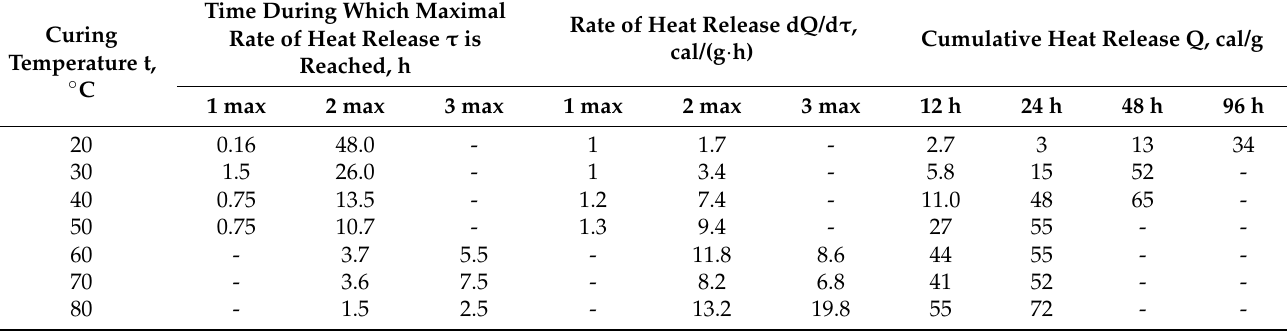
Table 4. The thermokinetic characteristics for the hydration process of the cement slag, clinker and Na 2 O · SiO 2 · 5H 2 O solution. Curing Temperature t, ◦